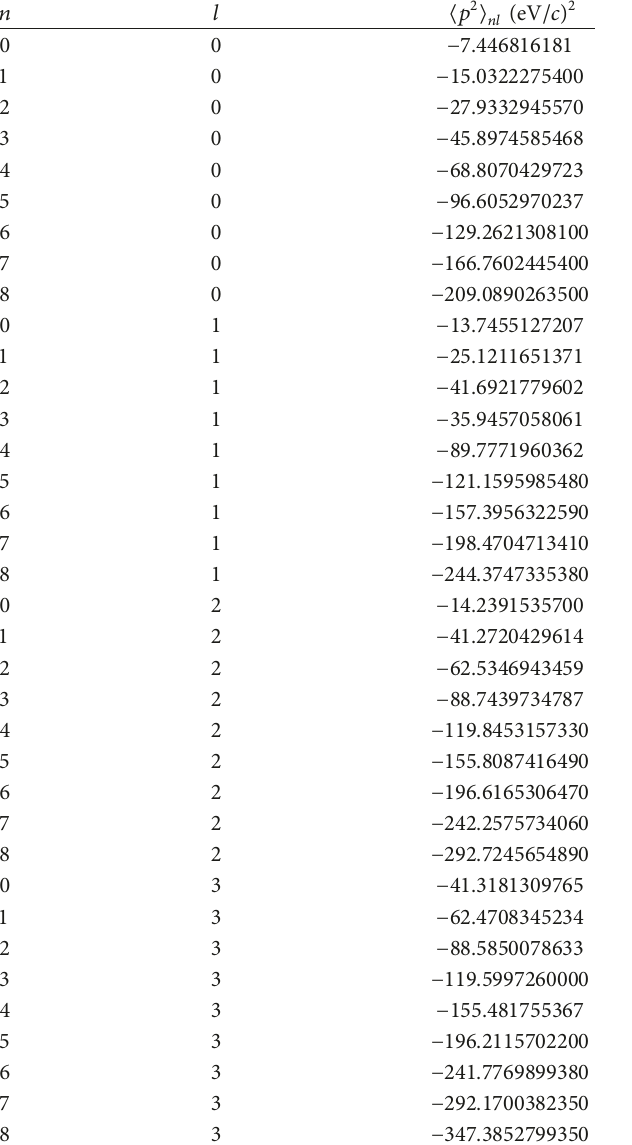
Table16:Expectation values of ⟨𝑝 2 ⟩ for hydrogen chloride molecule. Table 17: Expectation values of ⟨𝑝 2 ⟩ for carbon ( 11 ) oxide molecule.